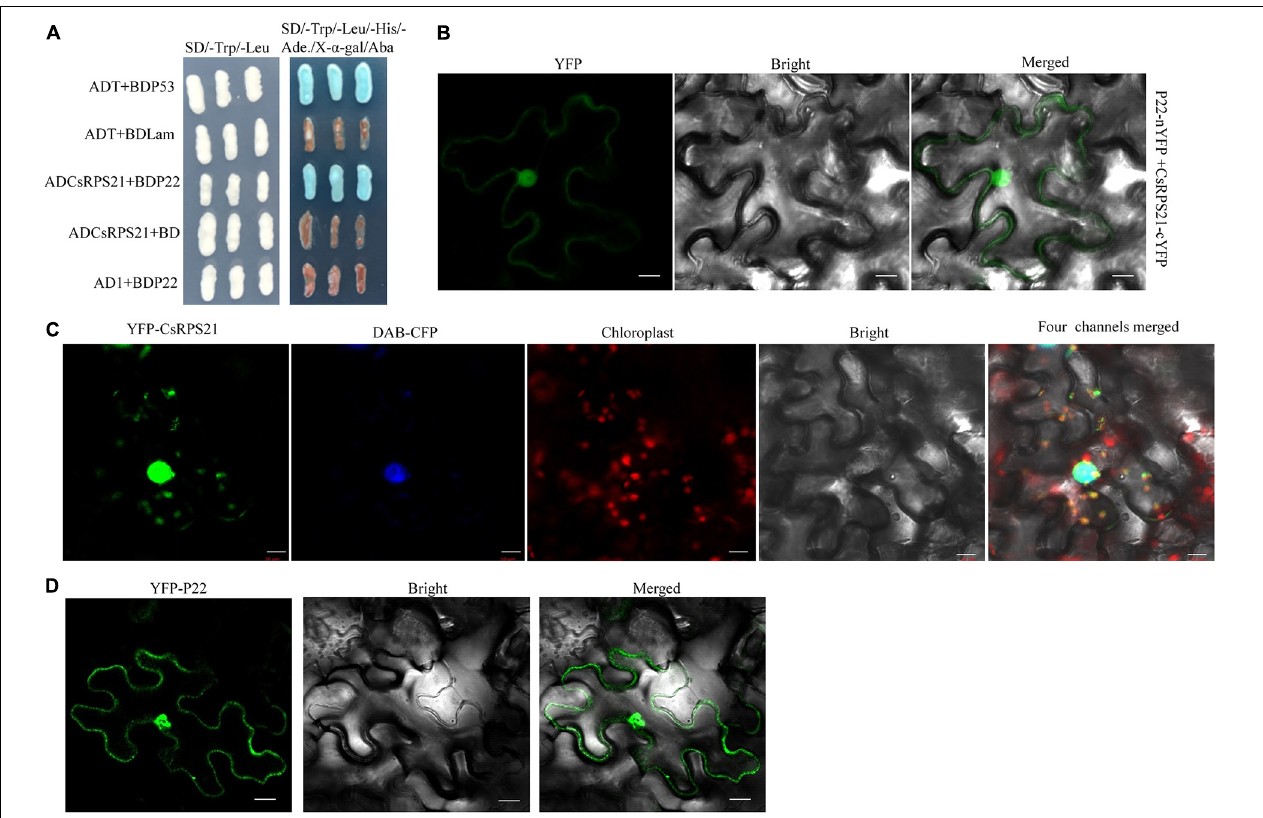
FIGURE 1 | Identification of the interaction between P22 and CsRPS21. (A) Growth of Y2HGold yeast cells co-transformed with ADCsRPS21 and BDP22 on low-(SD/–Trp/–Leu) and high-(SD/–Trp/–Leu/–His/–Ade/Aba/X- α -gal) stringency selection media. ADT + BDP53 and ADT + BDLam served as positive and negative controls, respectively. (B) Visualization of the interaction between P22 and CsRPS21 in N . benthamiana epidermal cells using BiFC. P22 fused with the N-terminal portion of YFP (P22-nYFP) was transiently co-expressed with CsRPS21 fused with the C-terminal portion of YFP (CsRPS21-cYFP). Bar represents 10 µ m. Photos were taken at 2 dpi using a Zeiss LSM710 laser scanning microscope. (C) Localization of CsRPS21 in N . benthamiana epidermal cells. YFP-tagged CsRPS21 (YFP-CsRPS21) was expressed in planta . Confocal images were taken at 2 dpi. Nuclear localization protein DAB-CFP was used as a nucleus indicator. Bar represents 10 µ m. (D) Localization of P22 in N . benthamiana epidermal cells. YFP-tagged P22 (YFP-P22) was expressed in planta . Confocal images were taken at 2 dpi. Bar represents 10 µ